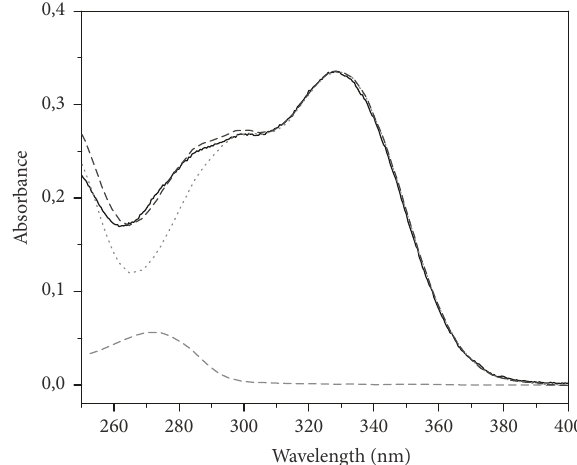
Figure 5: UV/Vis absorption spectra of coffee chemical extraction forR2sample(blackcontinuousline),ofcaffeineaftermultiplication for 𝑘 1 (greydashedline),andofCGAaftermultiplicationfor 𝑘 2 (grey dotted line). In black dashed line the spectral overlap of the caffeine and CGA is